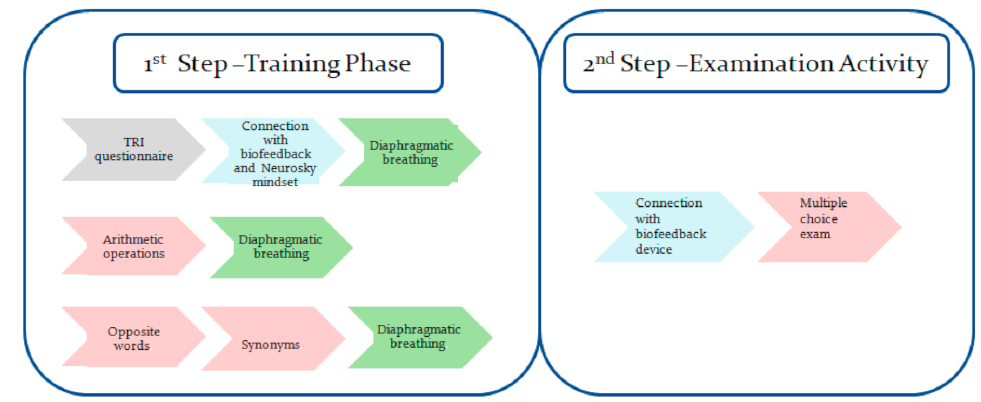
Figure 6. Procedure protocol of Experiment